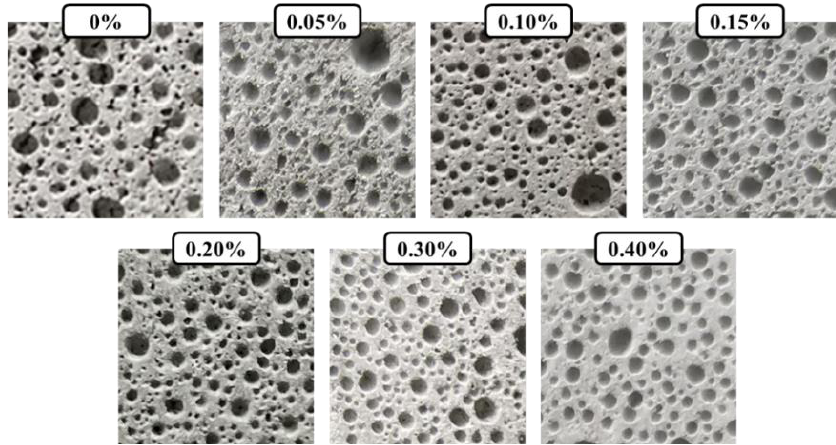
Figure 4. The pore structure of CHF foam fibers captured by a high-definition camera.